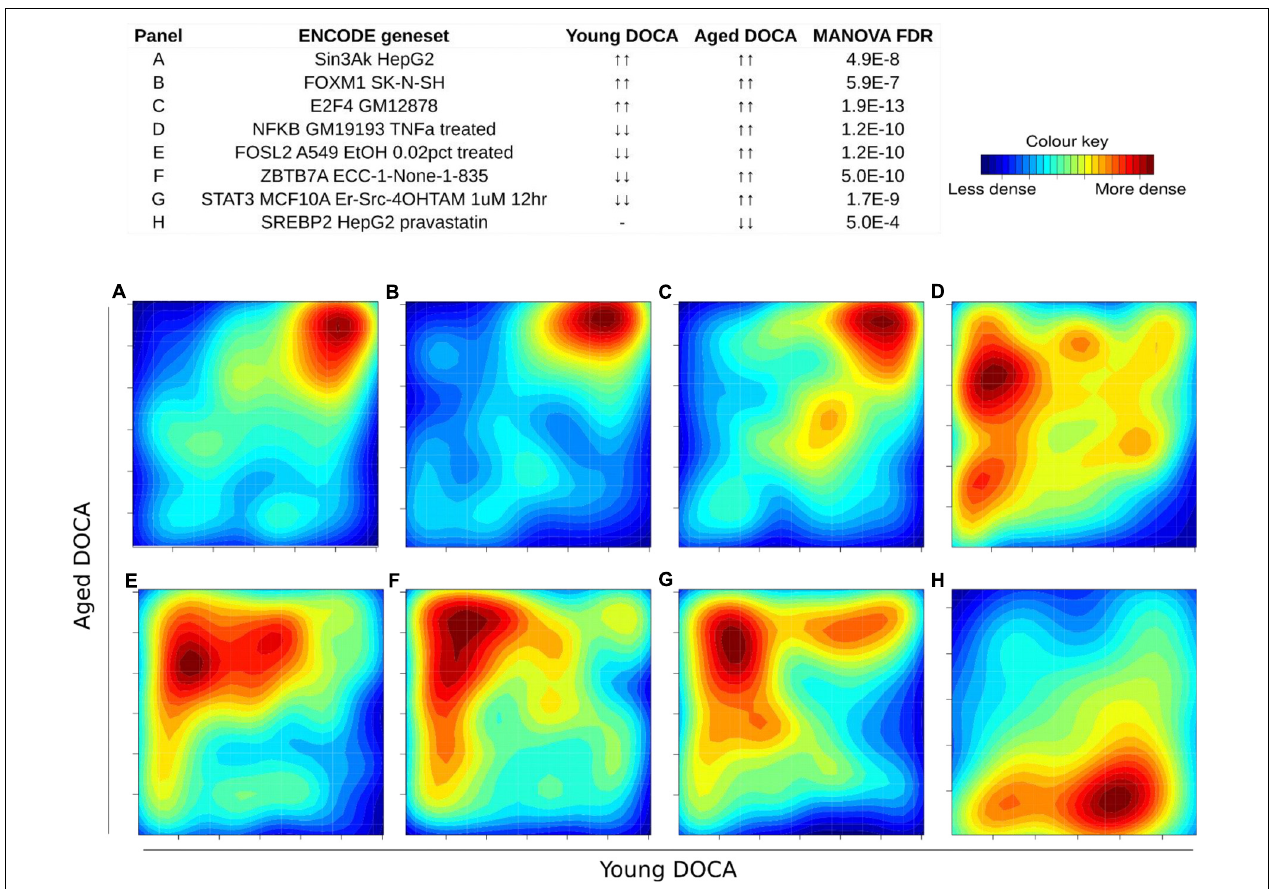
FIGURE 9 | Two-dimensional pathway analysis of transcription factors, showing up-regulation of (A) Sin3A, (B) FOXM1, and (C) E2F4 targets. However, it caught our attention that very few were down-regulated in both ages with the DOCA phenotype. There were several transcription factors with increased expression in older hearts and lower expression in younger hearts, including (D) Nfkb , (E) Fosl2 , (F) Zbtb7a , and (G) Stat3 . (H) On the other hand there were few with increases in young hearts and decreases in older hearts, the best example being Srebp2 . Sample size: n = 6 young DOCA vs. n = 4 aging DOCA